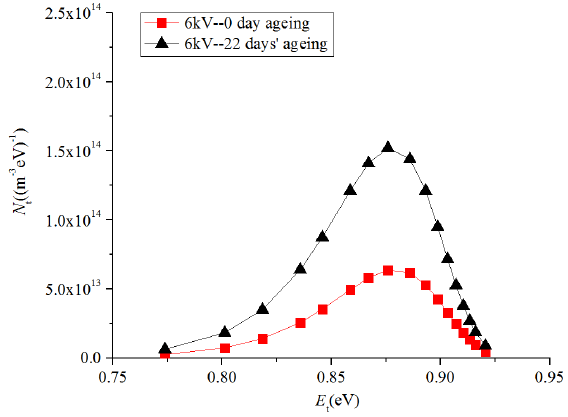
Figure 10. Trap energy distributions for samples with new oil and seriously aged oil under different voltages at 15 °C [20].